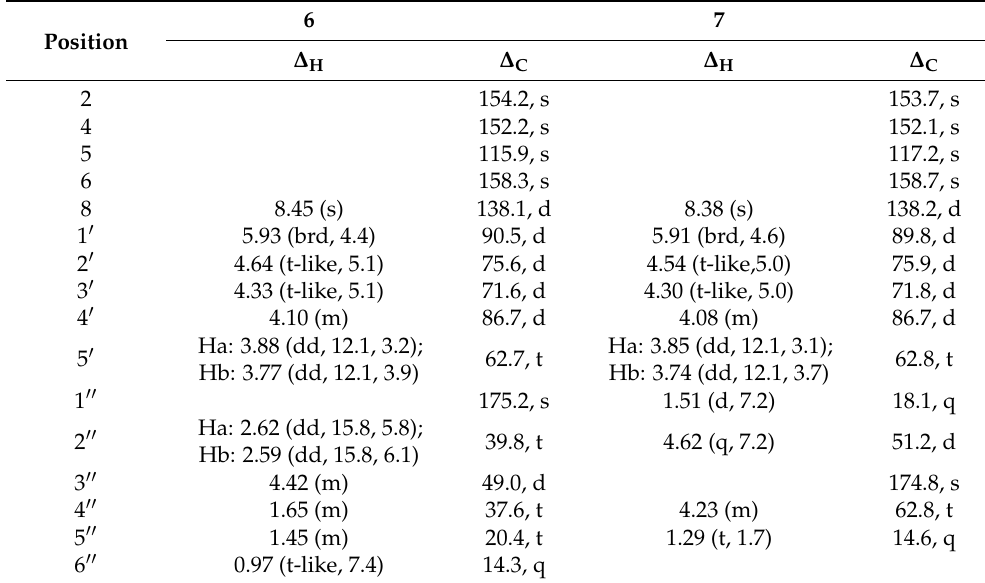
Table 2. 1 H- (600 MHz) and 13 C-NMR (150 MHz) data of 6 and 7 in methanol- d 4 ( ∆ in ppm, J in Hz).